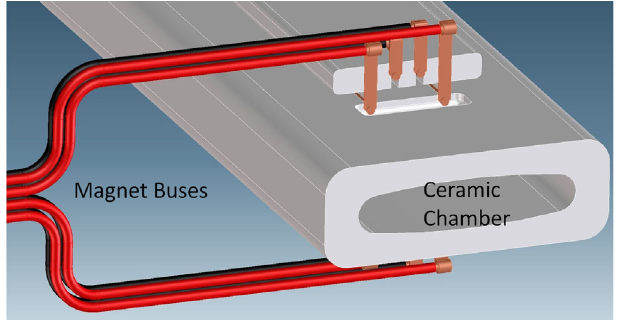
FIG. 7. Finite conductors model (a) and its vertical magnetic field (b) compared to the infinite long conductor model. FIG. 8. The prototype of the ALS NLK